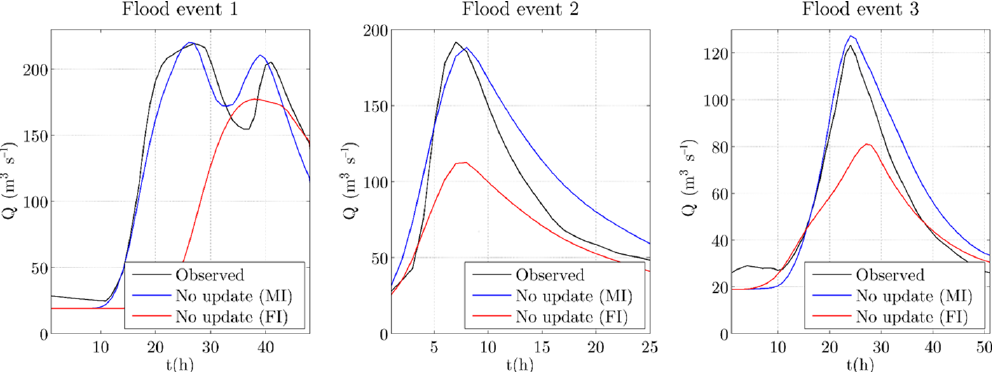
Figure 13. Observed and simulated hydrographs, without updates, using measured input (MI) and forecasted input (FI), for the three consid- ered flood events which occurred in 2013 (event 1), 2014 (event 2), and 2016 (event 3) in the Bacchiglione